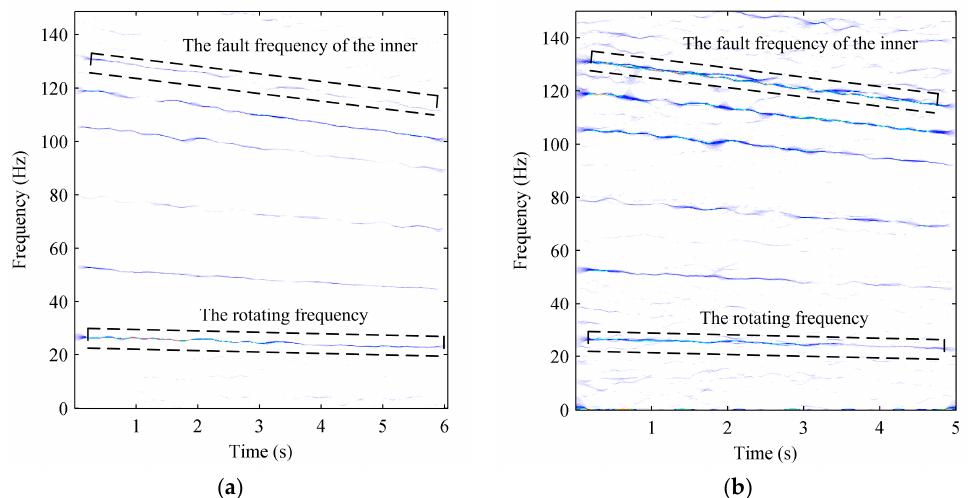
Figure 12. TFRs of the bearing signal: ( a ) TFR obtained by SST; ( b ) TFR obtained by the proposed method.